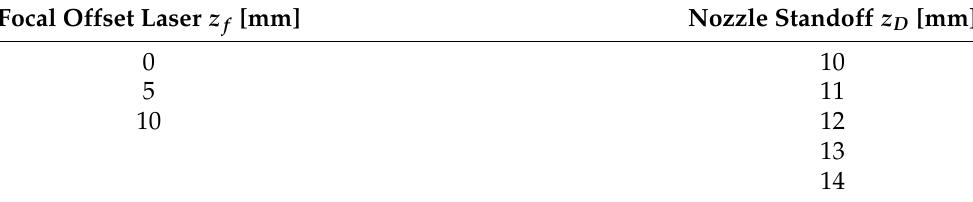
Table A6. Full-factorial design to investigate the interdependencies of focal offset and nozzle standoff.